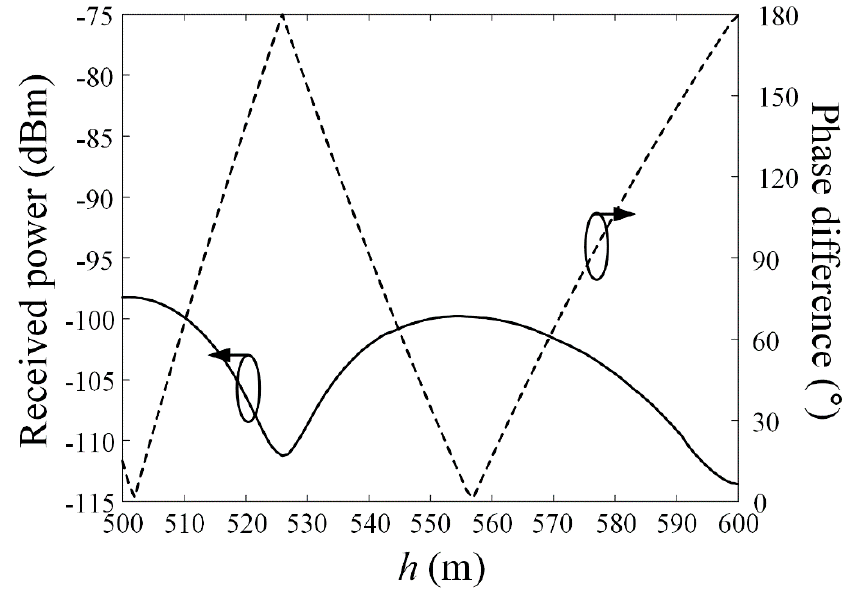
Figure 10. Received power and the phases di ff erence between the direct and reflected rays.